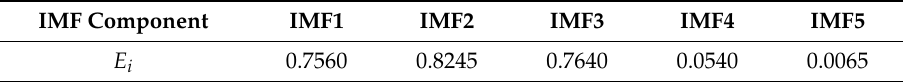
Table 3. Intrinsic mode functions (IMF) component validity.